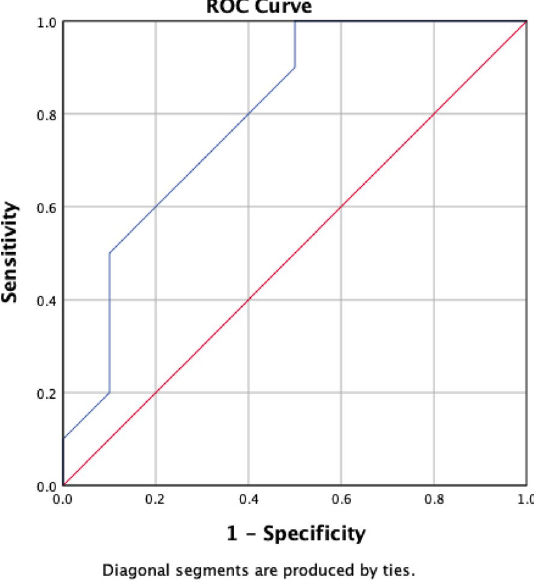
Fig. 2 TNF-alpha ROC curve for predict angina pectoris vs.